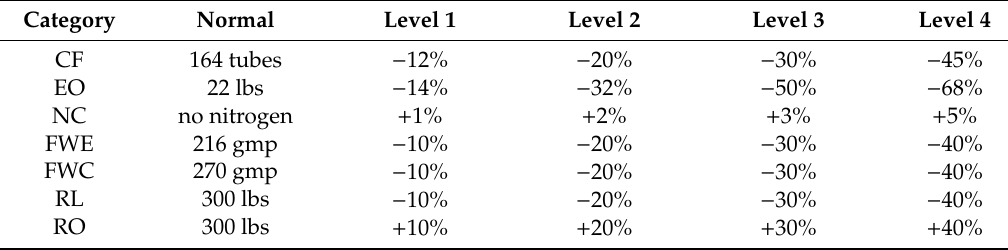
Table 2. Fault Level Classification.